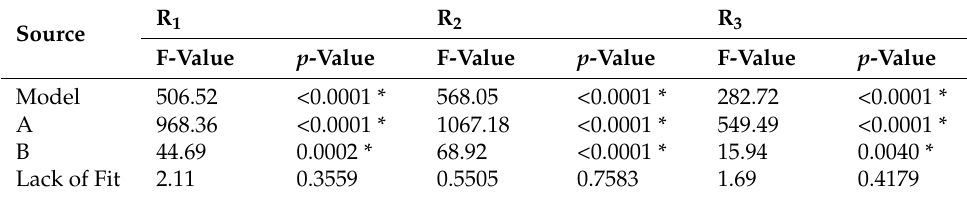
Table 3. Statistical analysis of all responses showing F-value, p -value, and lack of